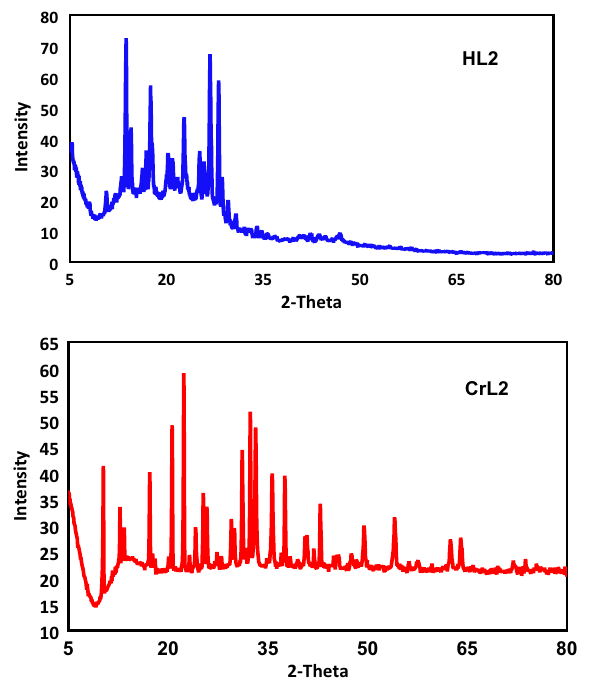
Figure 4. HL2 and its CrL2 complex’s PXRD pattern ( A ) ( B ).